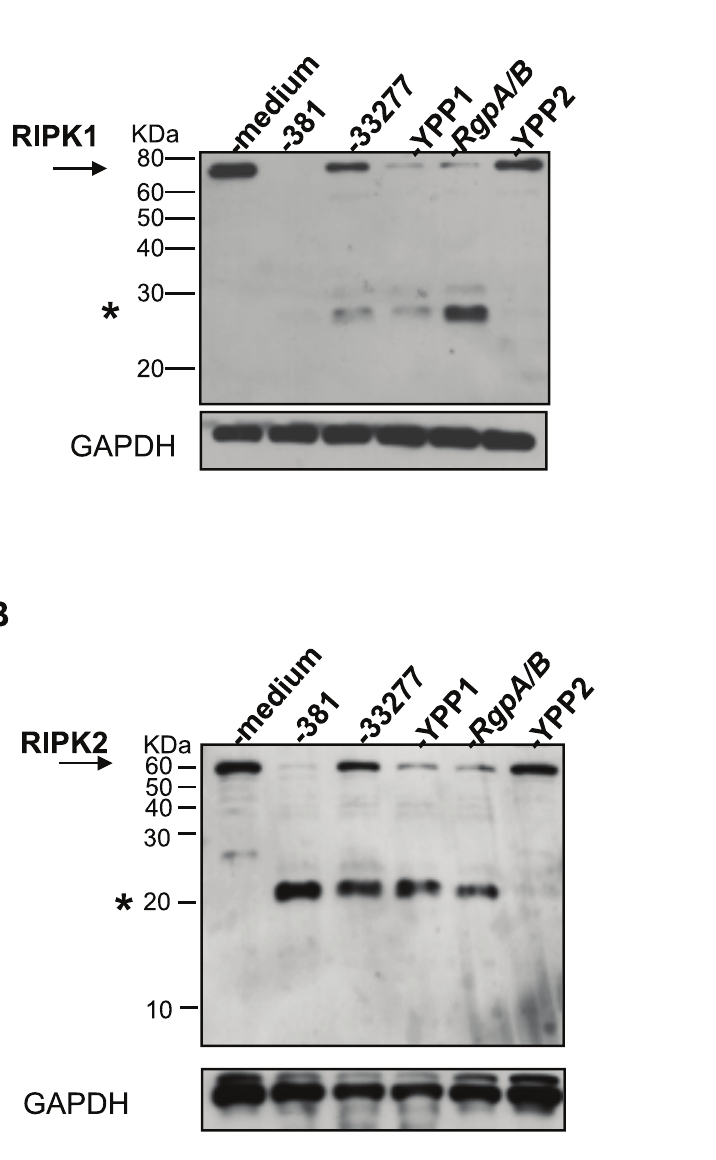
Figure 9. P.gingivalis Kgp mutant is deficient in the induction of RIPK1 and RIPK2 proteolysis in HAEC. HAEC were untreated or treated with P. gingivalis strain 381, strain ATCC 33277, or isogenic mutants of 33277: YPP1 ( rgpA 2 ), RgpA/B ( rgpA 2 , rgpB 2 ), or with YPP2 ( kgp 2 ) (MOI 100) for 2 h. Whole cell lysates were analyzed for A ) RIPK1 or B ) RIPK2. Full-length RIPK1 and RIPK2 are indicated with arrows. Prominent P. gingivalis -induced LMW bands are indicated with asterisks. MW ladder is indicated on the left in kDa. GAPDH was detected as a loading